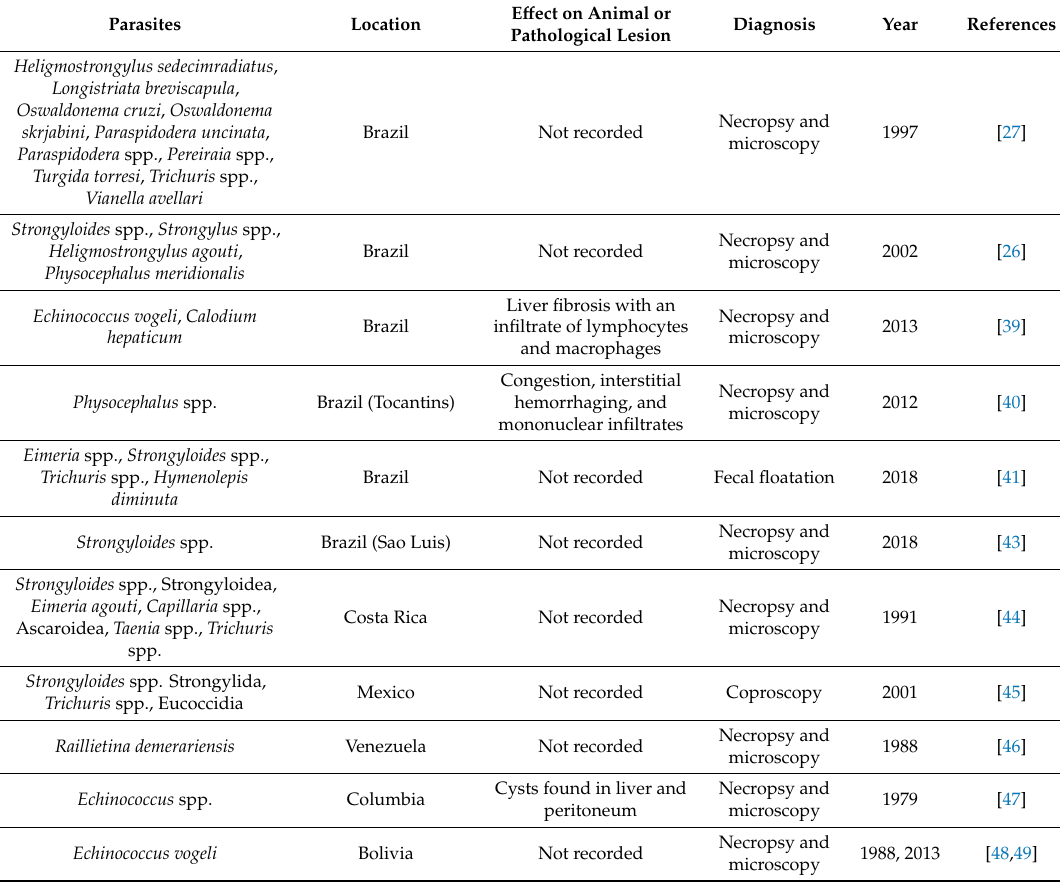
Table 2. Endoparasites found in the lappe ( Cuniculus paca / Agouti paca ) at di ff erent locations. Parasites Location